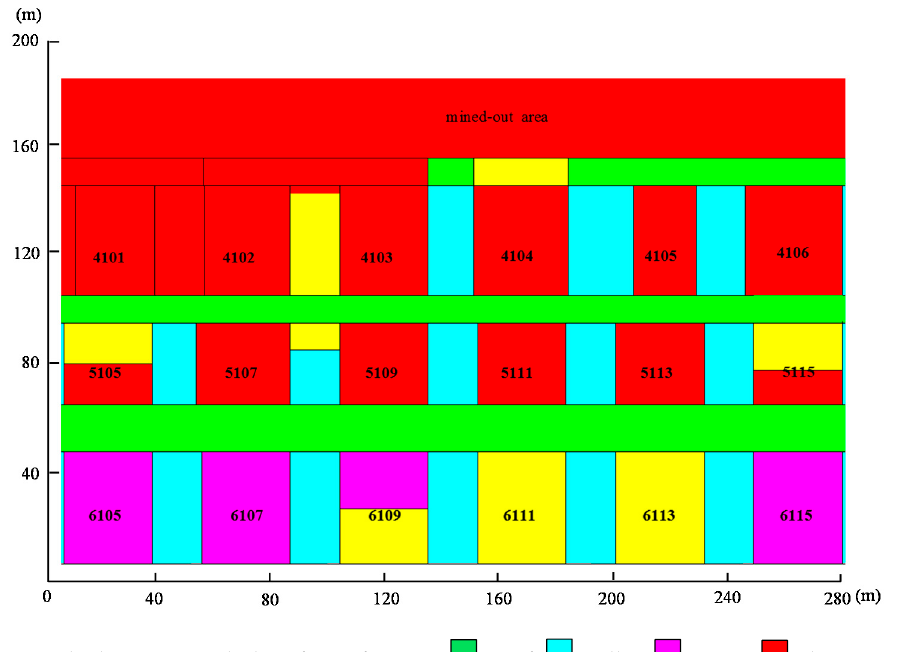
Figure 10. The locations and identifiers of rooms: : roof; : pillar; : room; : the mined-out area; : the recovering area. Table 2. Mining time and mining process. Time Interval Time